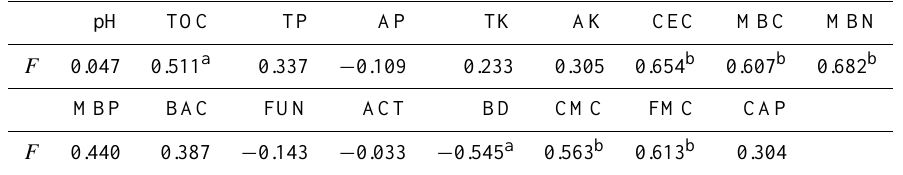
Table 5. Correlation analysis of integrate fertility scores ( F) with soil